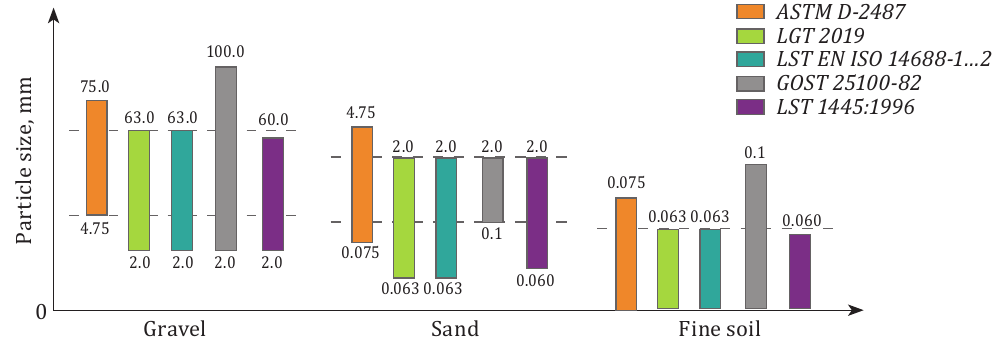
Figure 2. Comparison of gravel, sand, and fine soil fractions confirming different normative